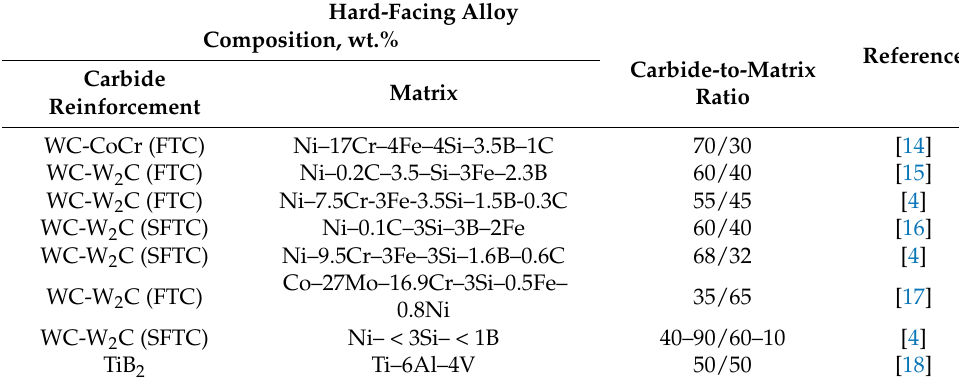
Table 2. Examples of chemical compositions of filler materials used to protect the working surface of drilling